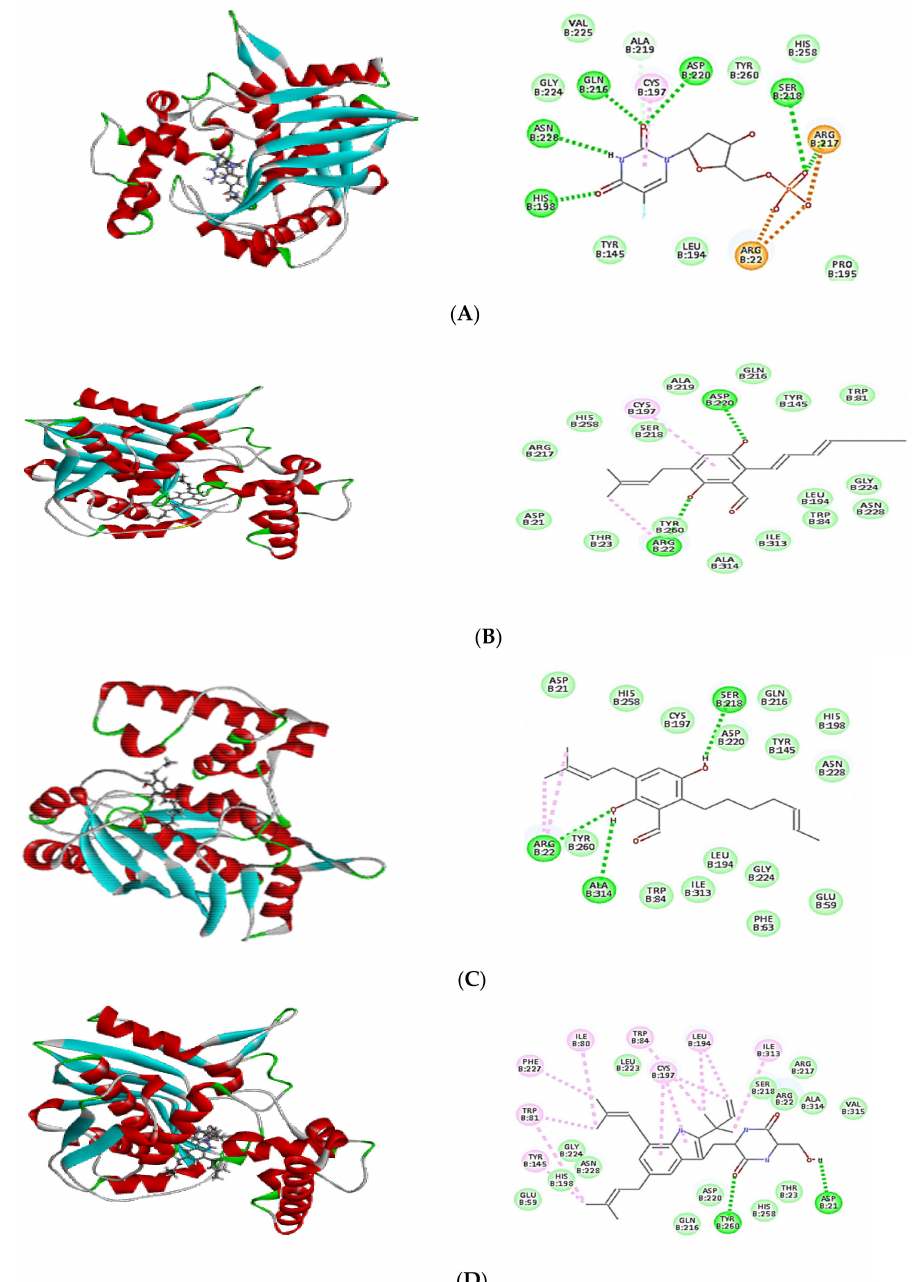
Figure 6. Two-dimensional (2D) and three-dimensional (3D) binding mode of the co-crystalized ligand (FFO) ( A ), dihydroauroglaucin ( B ); isotetrahydroauroglaucin ( C ); cristatumin B ( D ) with thymidylate synthase. Residues are labeled with their three-letter amino acid code and their location. Hydrogen-bonding interactions are depicted by a green dashed line between the receptor and the ligand, whereas π –alkyl interactions are represented by a purple dashed